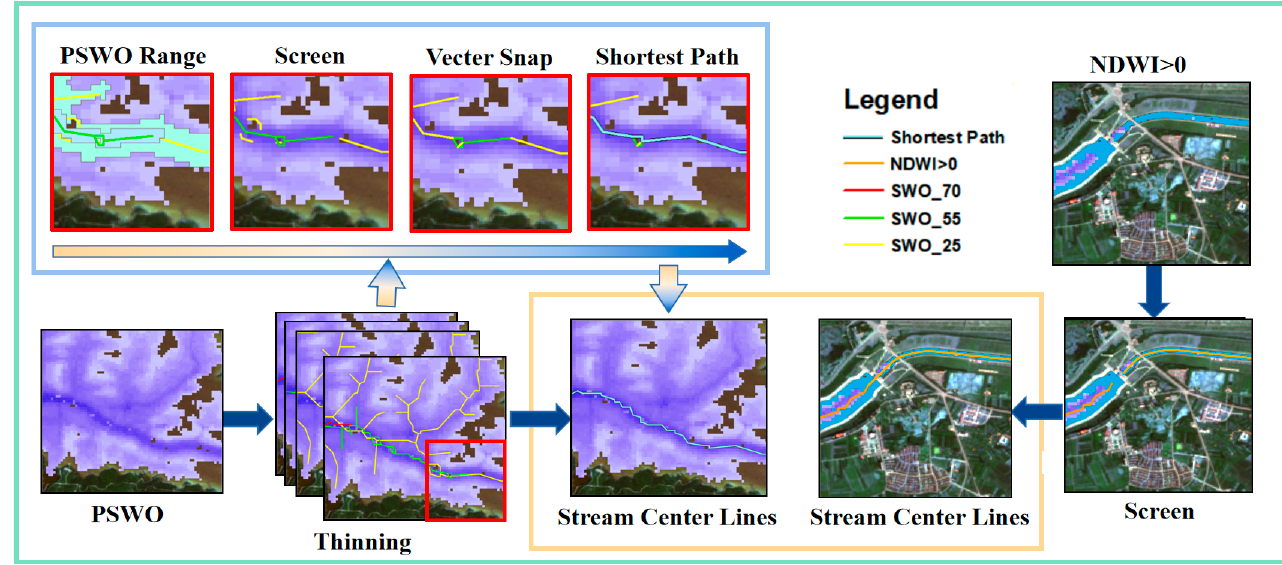
Figure 4. Extraction of the skeleton lines of hydrography layers.